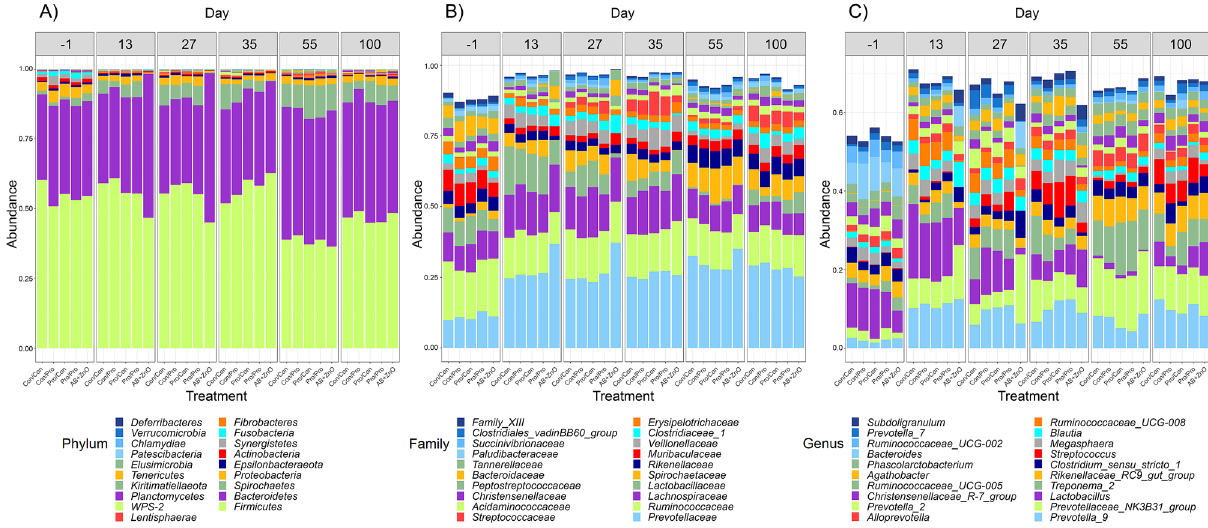
Figure 4. Mean relative abundances (%) of bacterial phyla ( A ), 20 most abundant families ( B ), and 20 most abundant genera ( C ) within the faeces of pigs across all sampling days and treatments ( n = 262). Treatments are as follows (1st stage weaner period/2nd stage weaner period): Con/Con, Con/Pro, Pro/Con, Pro/Pro, and AB + ZnO; where Con = control; Pro = probiotic and AB + ZnO = antibiotic +